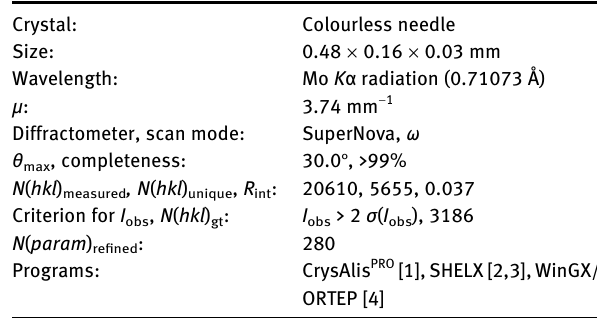
Table  : Data collection and handling. Crystal: